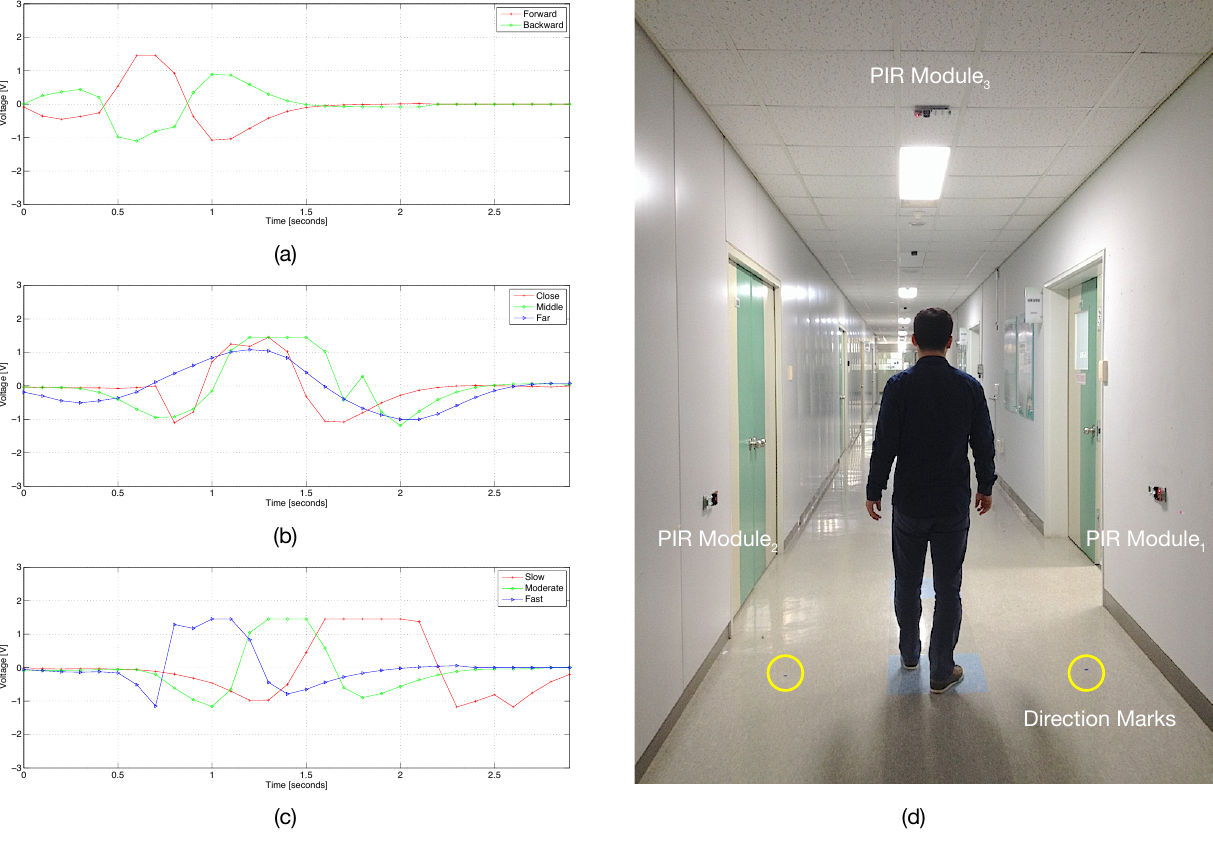
, A , A ) and time (T 1 2 3